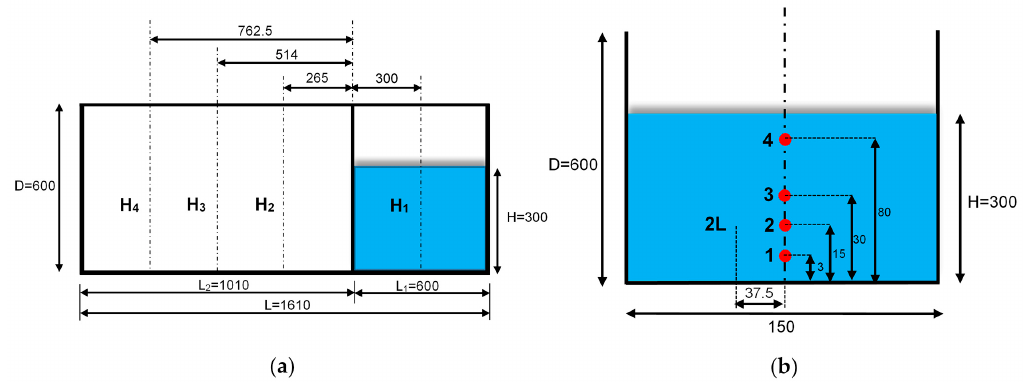
Figure 1. Experimental set-up: ( a ) water level measuring position on the left (lateral view); ( b ) pressure sensor locations on the right (frontal view). Dimensions are in millimeters.